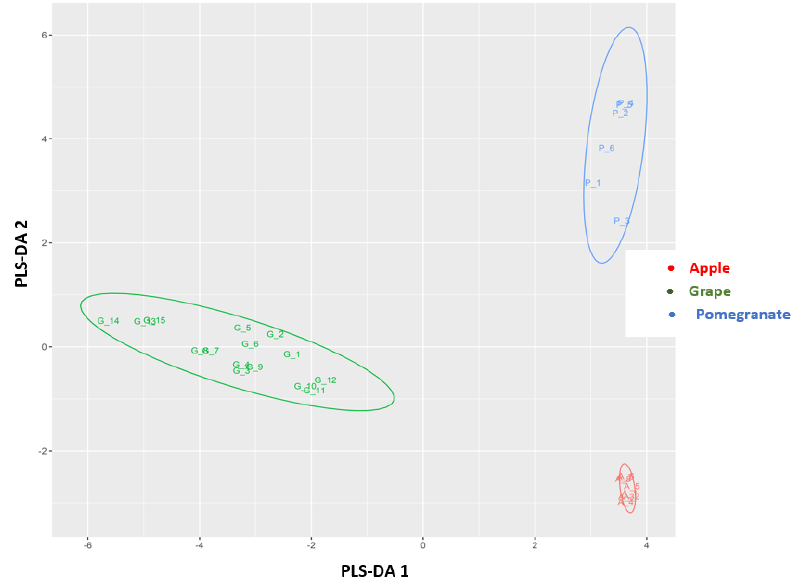
Figure 4. Principal component analysis (PCA) score plot showing the classification of authentic pomegranate, apple, and red grape juice samples.